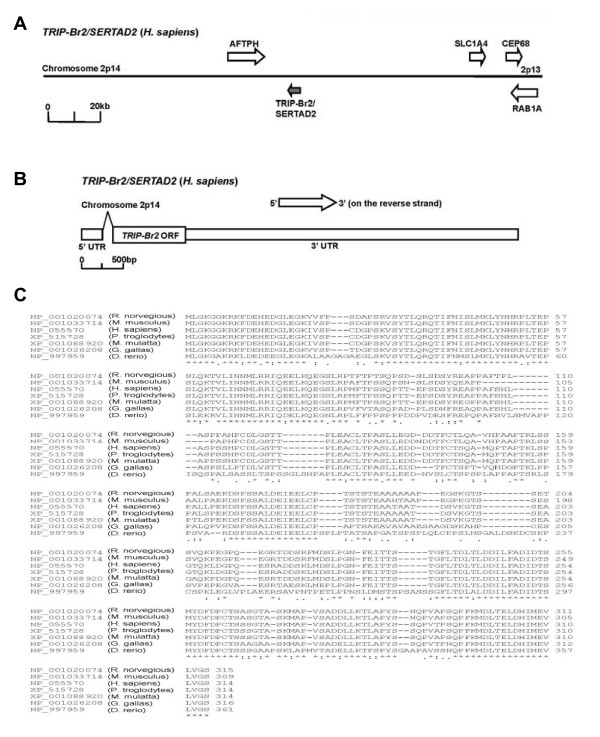
Gene structural organization of human TRIP-Br2. (A) TRIP-Br2 is localized at chromosome 2p14 of the human genome (B) TRIP-Br2 consists of two exons that are separated by an intron encoding splice donor-acceptor (GT-AG) sequences at either end. (C) Multiple sequence alignment of TRIP-Br2 proteins from widely divergent species by BLAST/ClustalW analyses.